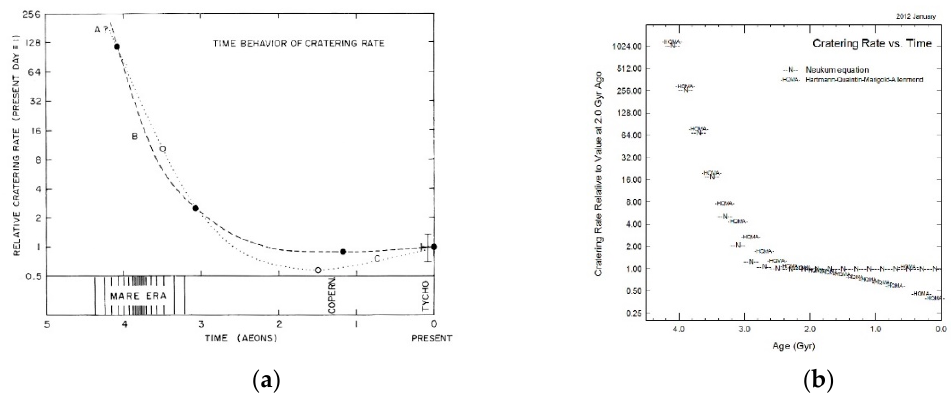
Figure 2. ( a ) A 1970 diagram of the decline in the impact cratering rate, relative to the present-day cratering rate, based on data from the earliest Apollo landing sites. Two different interpretations are shown, but both agree on a decay by roughly 6 half-lives between 4.0 and 3.0 Ga ago (Hartmann 1970b [32]). ( b ) Two post-Apollo solutions for cratering rate as a function of time, by Neukum et al. (2001, [38]) and Hartmann et al. (2007 [42]).